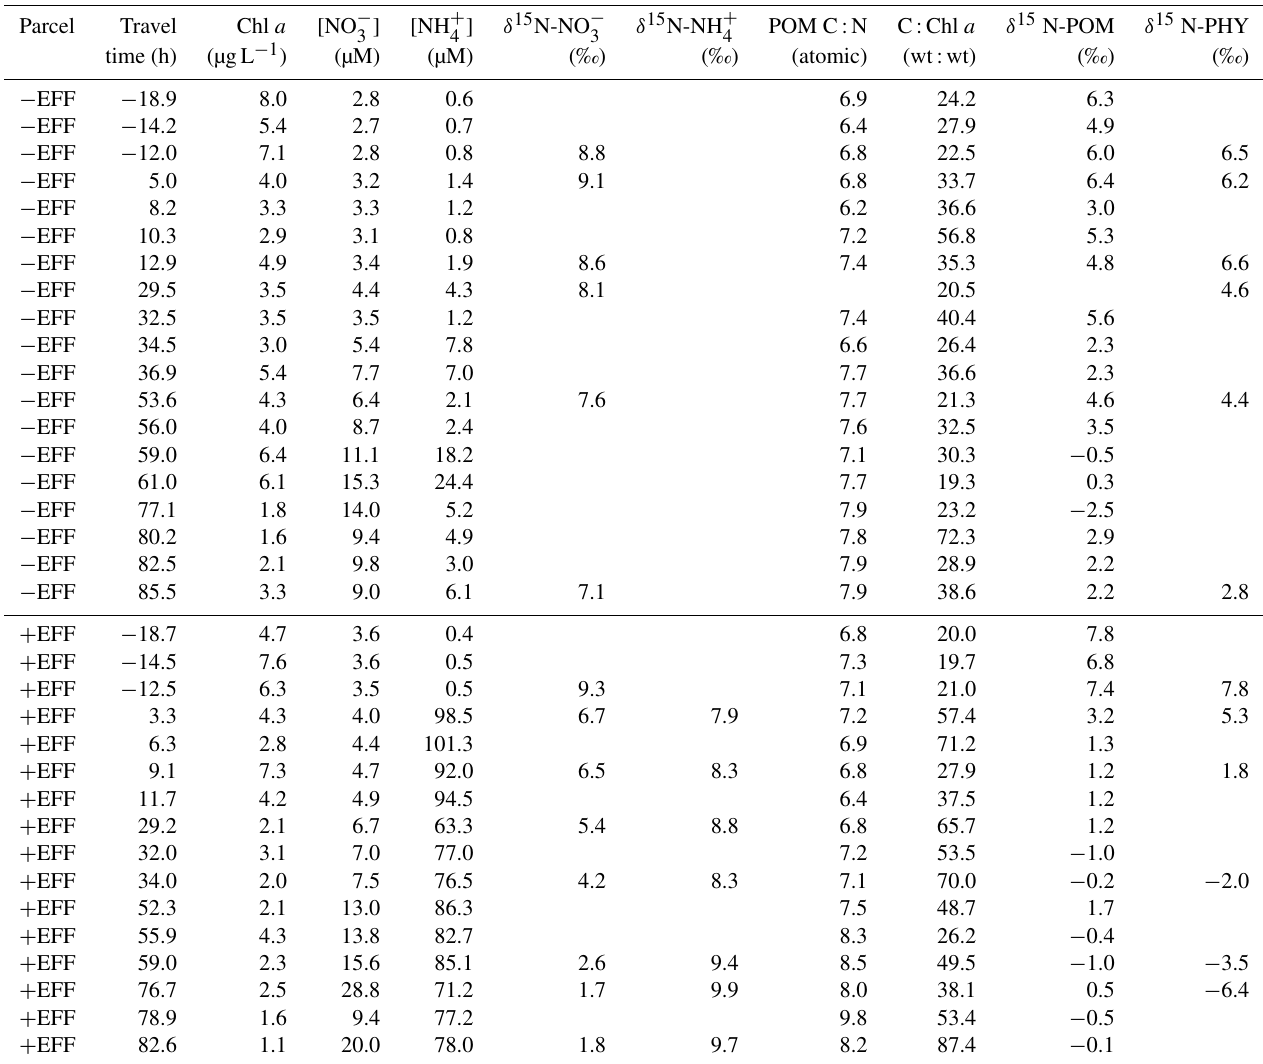
Table 1. Summary of conditions in the two water parcels sampled in October 2013; one parcel did not receive effluent ( − EFF) and one parcel did receive effluent ( + EFF) as it passed the wastewater treatment plant (WWTP). A travel time of zero represents the time each parcel passed the location where effluent from the WWTP enters the